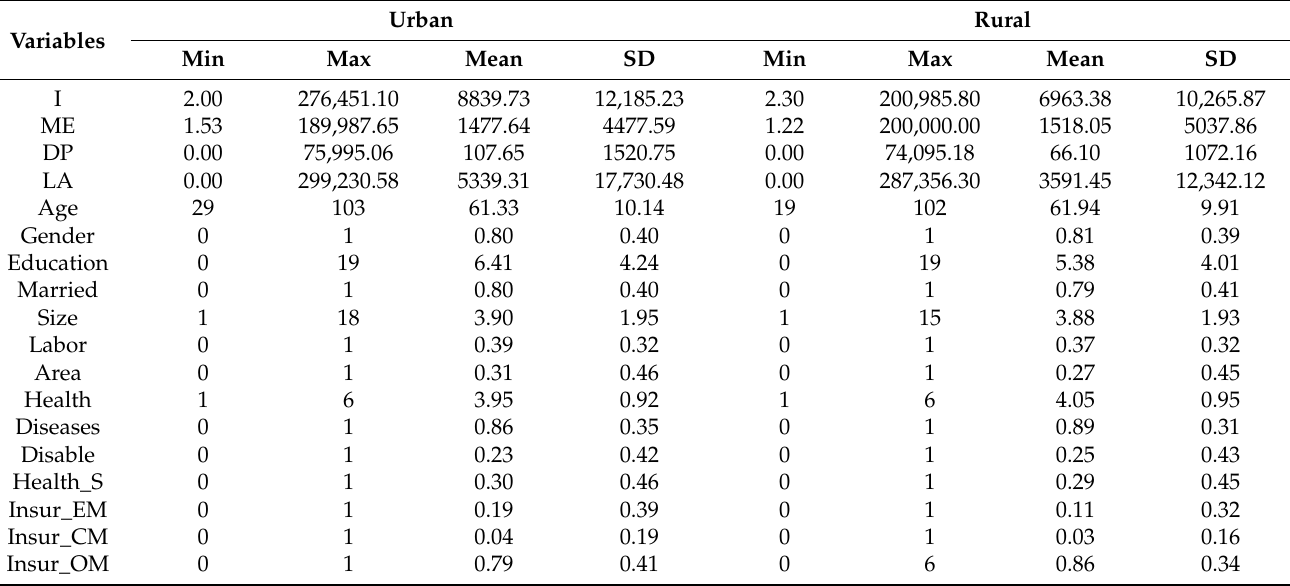
Table 2. Description